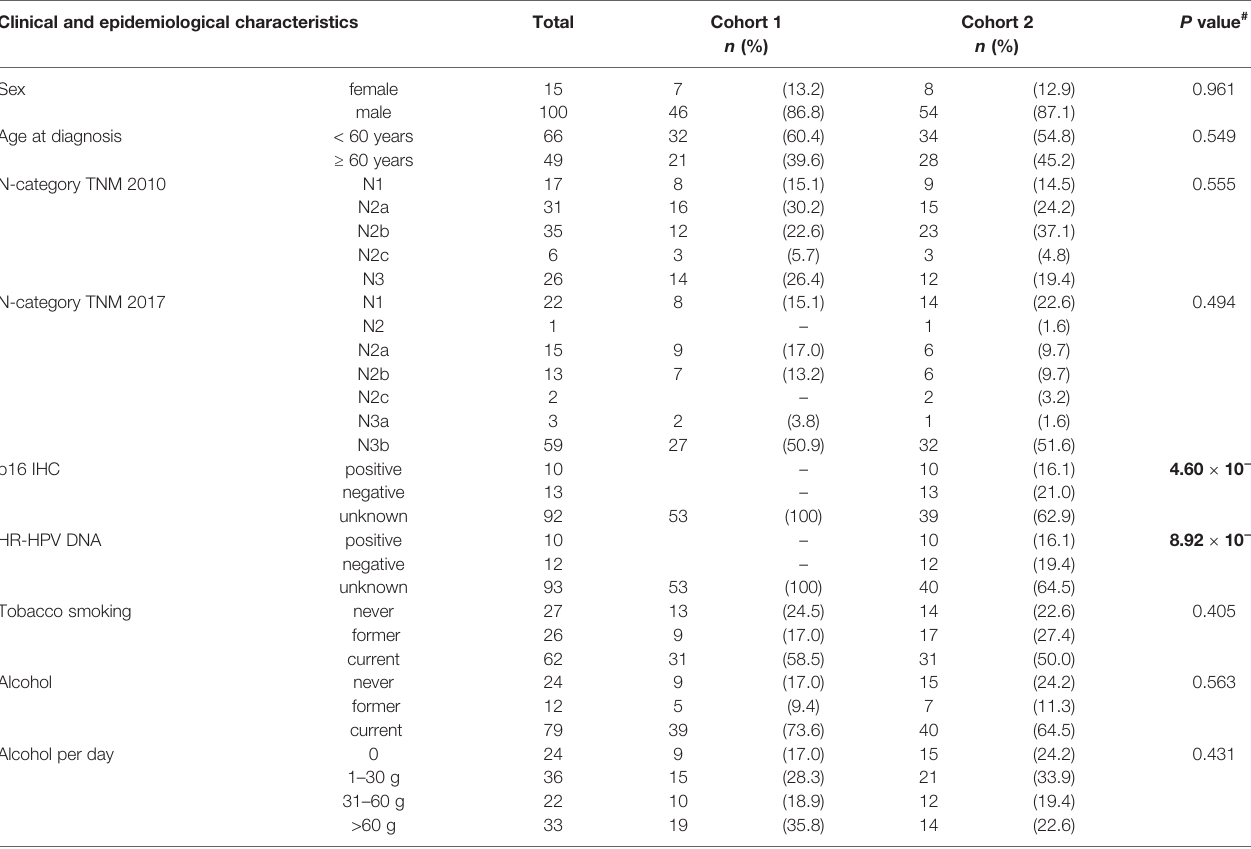
TABLE 1 | Clinical and epidemiological characteristics, diagnostic procedures and treatment of neck squamous cell carcinoma of unknown primary (NSCCUP) patients of cohorts 1 and 2. Clinical and epidemiological